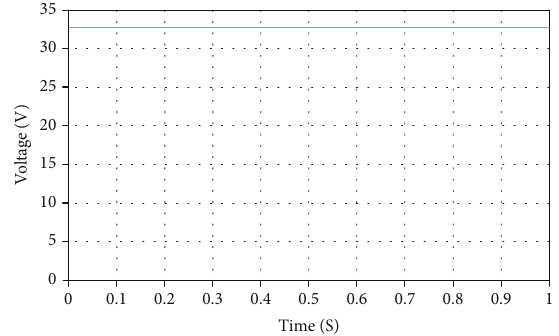
Figure 35: The output voltage of PV1.